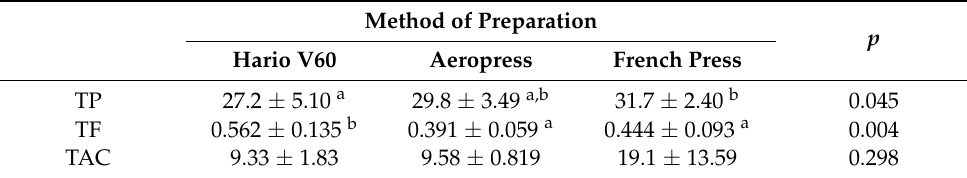
Table 2. Effect of method of coffee preparation on TP ( µ g GAE/mg), TF ( µ g QE/mg), and TAC ( µ g TE/mg) in specialty coffees (means ± SDs, n =